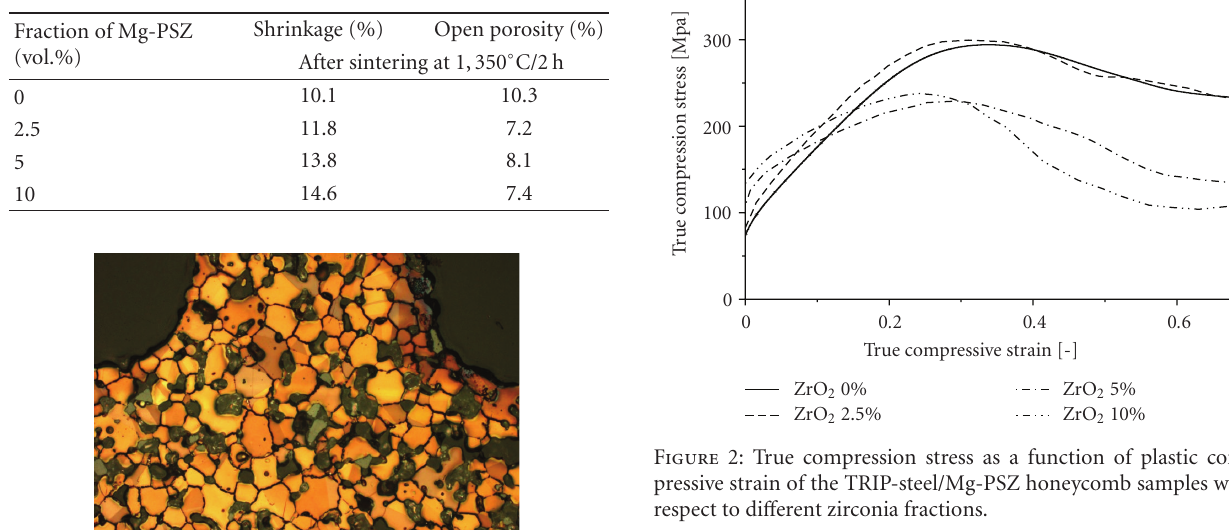
Table 1: Average shrinkages and open porosities of sintered honey- comb specimens.